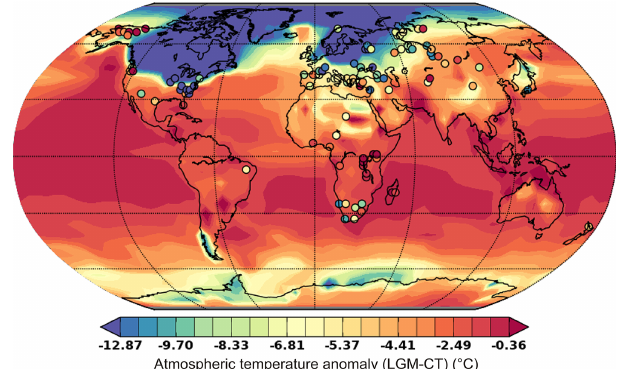
Figure 3. Comparison between simulated atmospheric temperature anomaly (LGM-CT) in i LOVECLIM and pollen-based continental climate reconstructions (Bartlein et al., 2011). For colour scale gen- eration explanations see Fig. 1